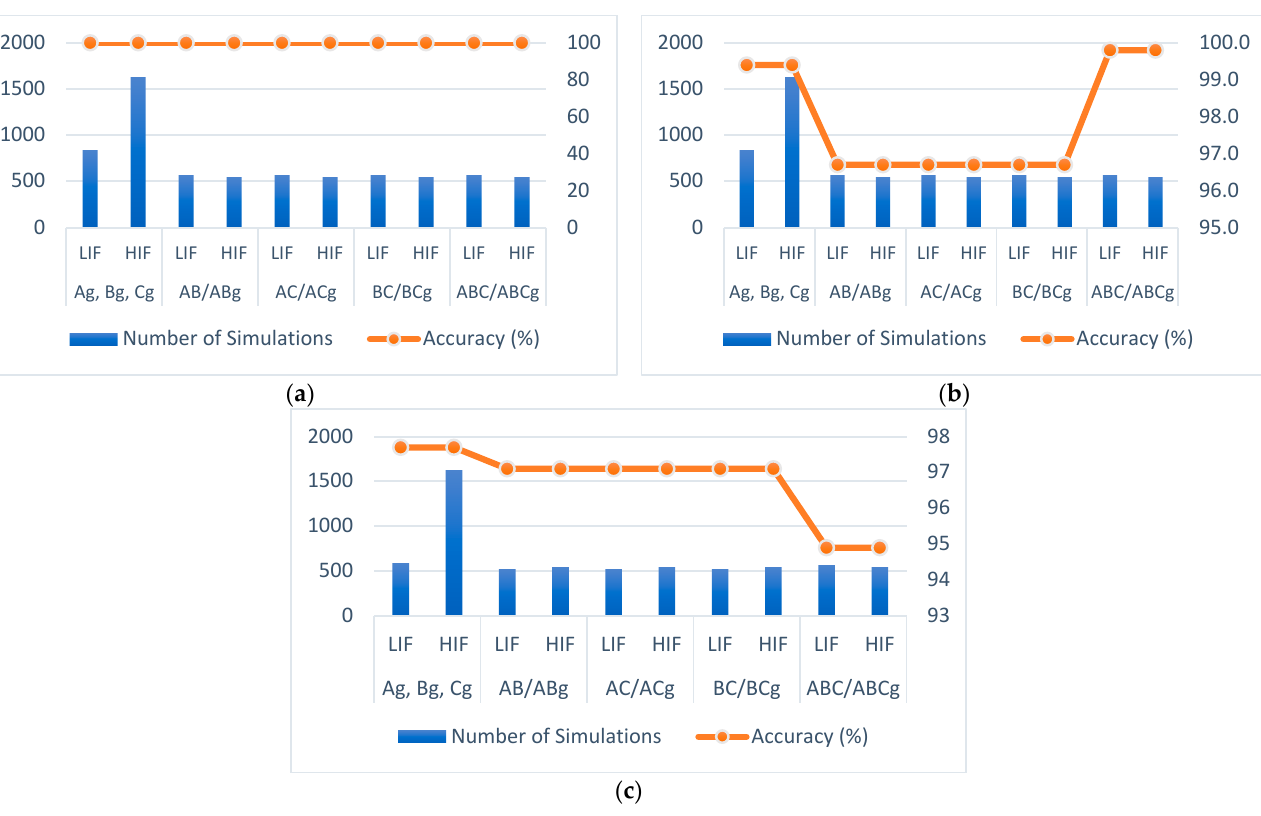
Figure 9. Short-circuit detection for three scenarios: ( a ) without DG units (scenario 1), ( b ) with two synchronous generators (scenario 2), and ( c ) with PV panels (scenario 3).